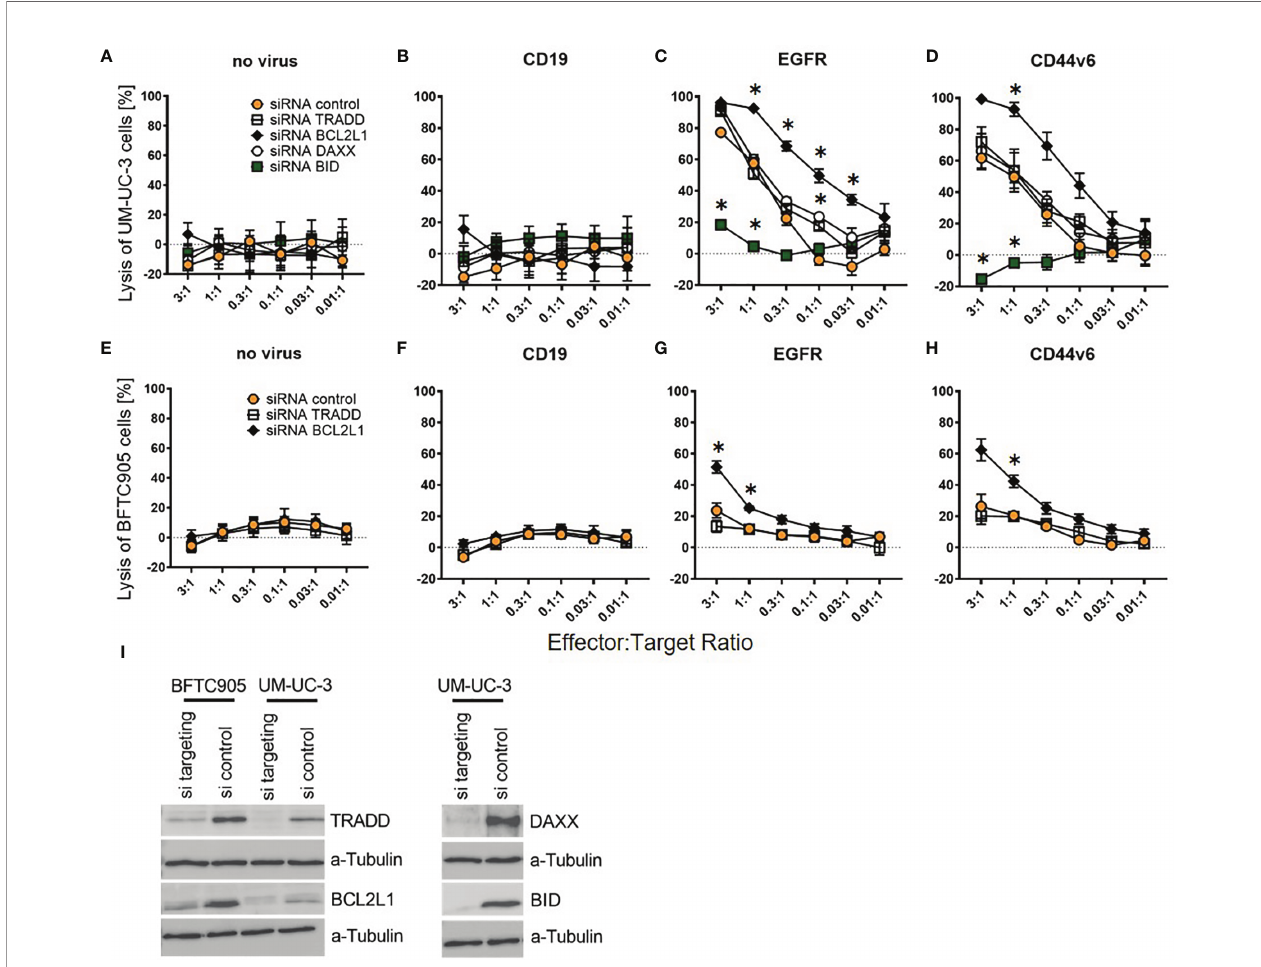
FIGURE 6 | Killing ef fi ciency of EGFR and CD44v6 CAR T-cells against UM-UC-3 and BFTC905 cells after siRNA knockdown of apoptosis regulating genes. (A) Cytotoxicity of untransduced (no virus), CD19, EGFR, and CD44v6 CAR T-cells against UM-UC-3 (A – D) and BFTC905 (E – H) cells transfected with indicated siRNA was determined. Graphs depict the mean values ( ± SD) of three independent experiments. Values for different effector to target ratios (E:T ratio 3:1 – 0.01:1) are given. (I) Western Blot analysis of TRADD (34 kDa), BCL2L1 (26 kDa), BID (22 kDa), and DAXX (110 kDa) protein expression after the respective siRNA knockdown (si targeting) compared to control cells (si control). Statistical signi fi cance (p-value <0.05) is denoted by asterisk and was determined by two-way ANOVA and Dunnett ’ s correction for multiple